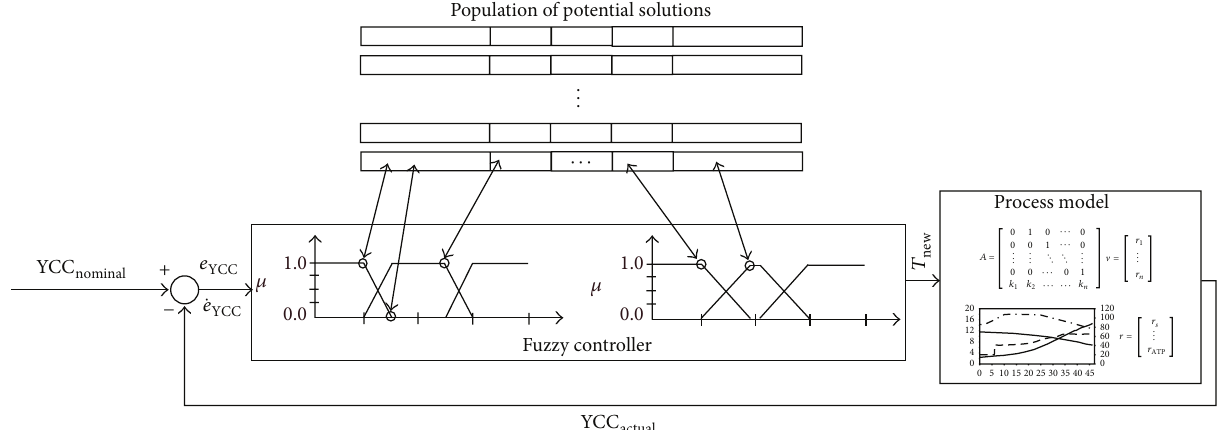
Figure 4: After initialization each individual of the population passes its parameter vector to the fuzzy controller. The controller is then simulated using the process model described in Section 2.1. Following the principle of elitism, the best solutions of each iteration are kept in order to create the next